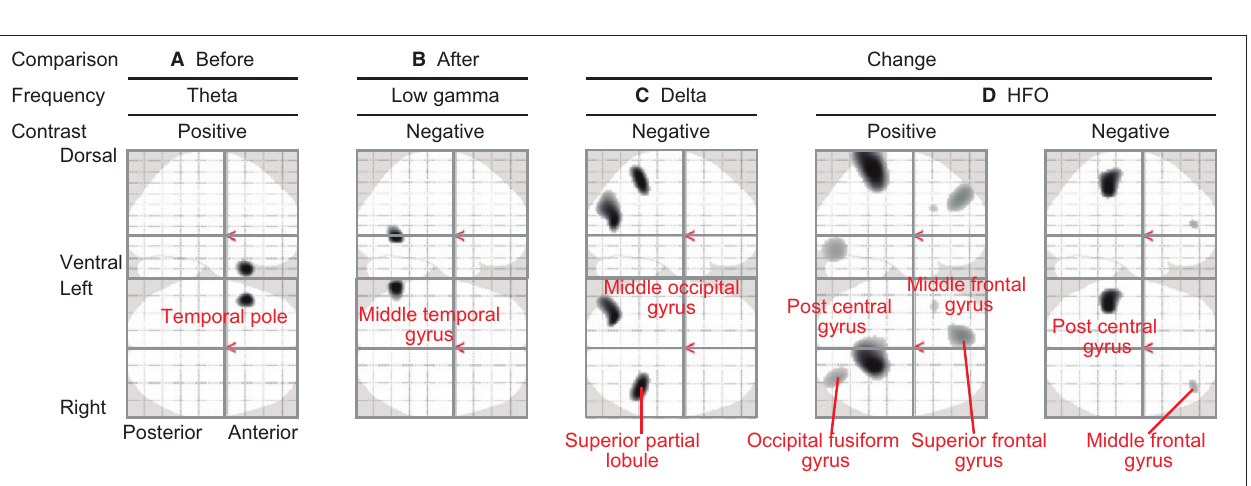
FIGURE 4 | Statistical parametric maps (SPMs) reporting the locations where regional oscillatory intensities were predicted by the subjective levels of pain. (A) SPM of the estimated oscillatory intensity in the theta band with pre-VAS as a regressor and positive contrast (pre-VAS comparison). (B) SPM of the estimated oscillatory intensity in the low gamma band with post-VAS as a regressor and negative contrast (post-VAS comparison). (C) SPM of the estimated oscillatory intensity in the delta band with the efficacy ratio as a regressor and negative contrast (change-VAS comparison). (D) SPMs of the estimated oscillatory intensity in the HFO band with the efficacy ratio as a regressor and positive (left panel)/negative (right panel) contrast (change-VAS comparison).